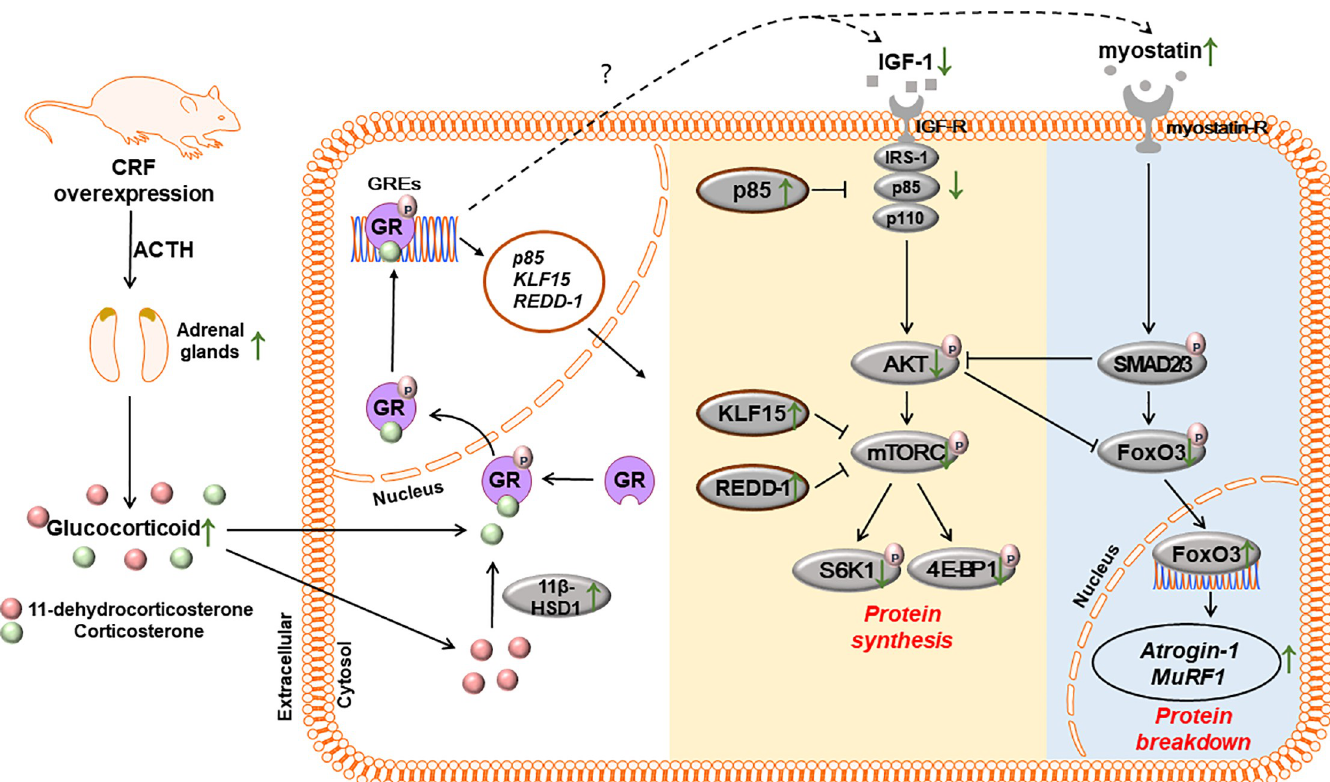
Fig 5. Schematic diagram illustrating the proposed mechanism of muscle atrophy in CRF-OE mice.